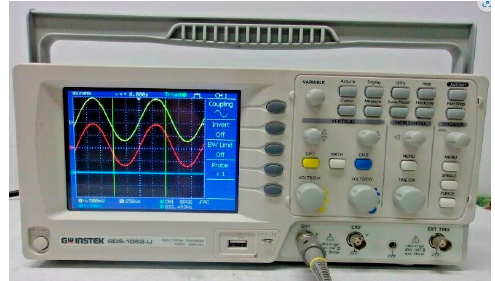
Figure 4. GDS-1052 digital storage oscilloscope.